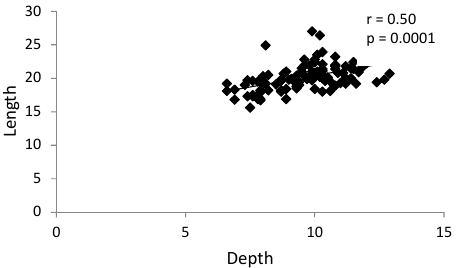
Figure 8. Graph presenting statistically significant positive correlation between the glenoid fossa depth and length in the control group (without TMJ reciprocal clicking).